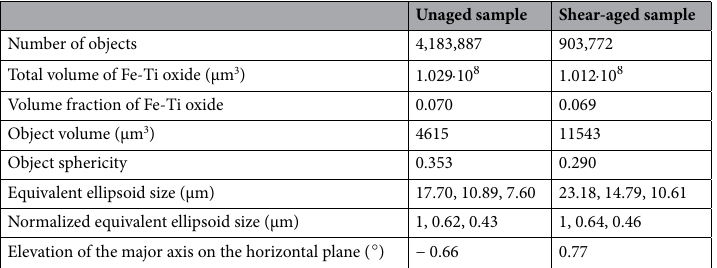
Table 1. Summary of 3D structures of Fe-Ti oxide aggregates in the unaged sample and clusters in the shear- aged sample. The five characteristics in the lower panel are median values from the